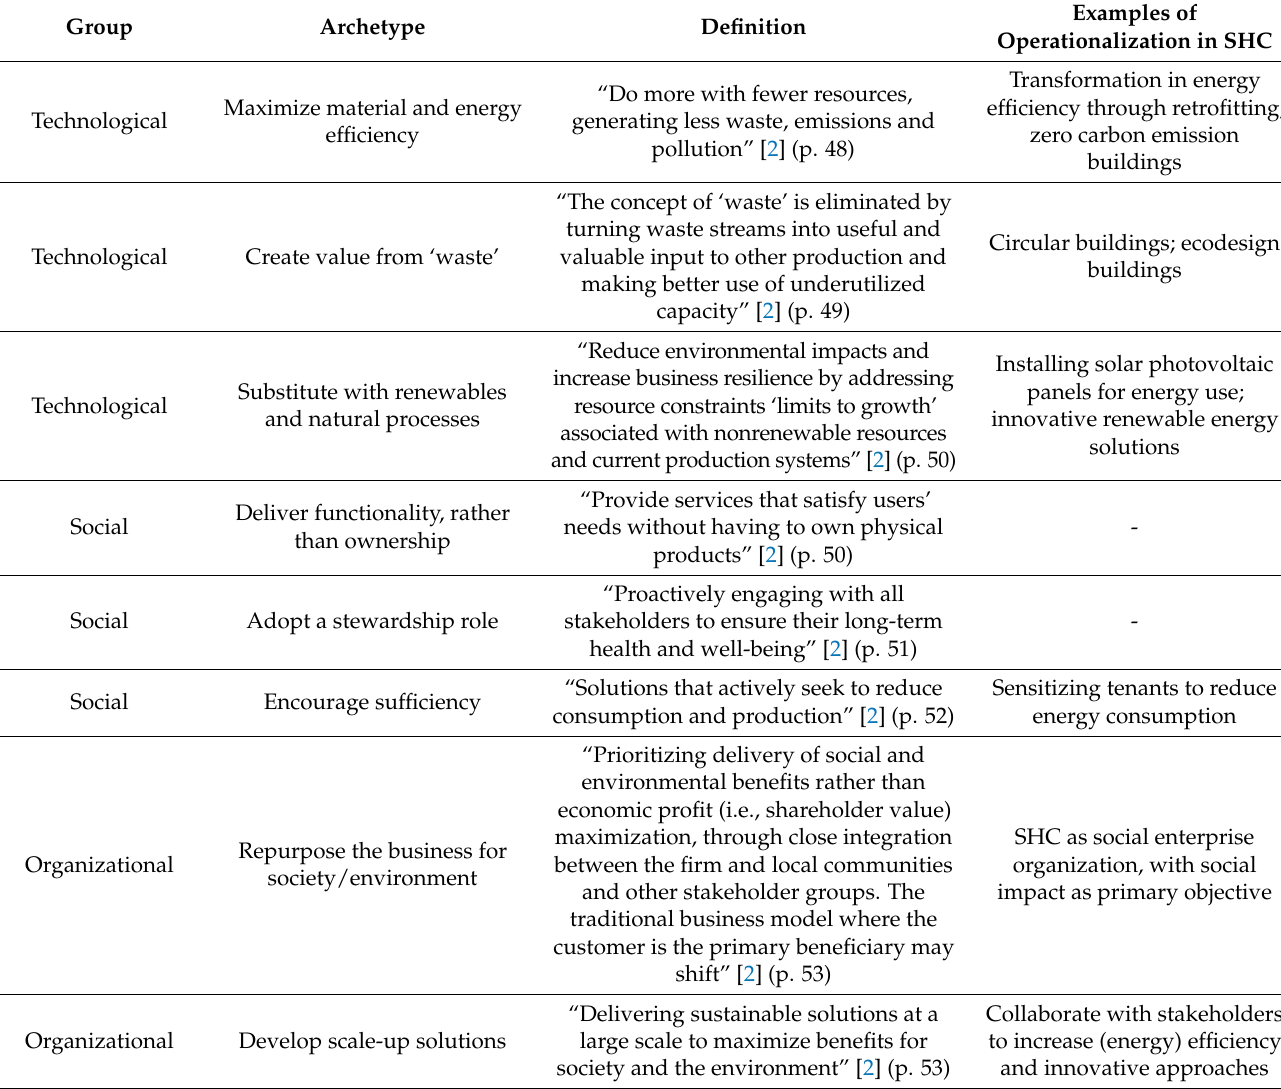
Table 1. Sustainable business model (SBM) archetypes in social housing